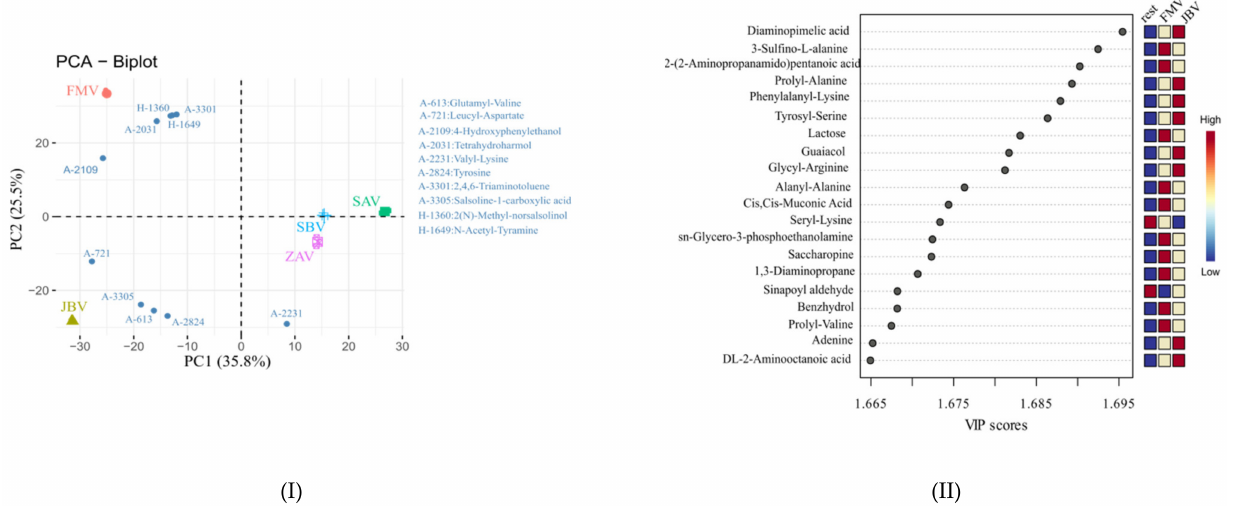
Figure 3. ( I ) PCA biplot of vinegar metabolites based on chemical isotope labeling LC-MS quantitative metabolomic analysis and ( II ) VIP score plot from partial least-squares discriminant analysis (PLS-DA) for FMV, JBV, and the rest (ZAV, SAV, and SBV).